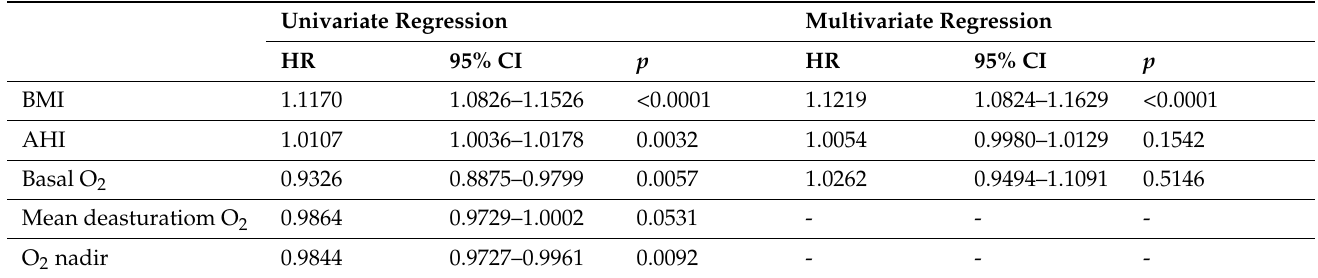
Table 3. Univariate and multivariate Cox regression analysis for development of DM2 at younger age. Univariate Regression Multivariate